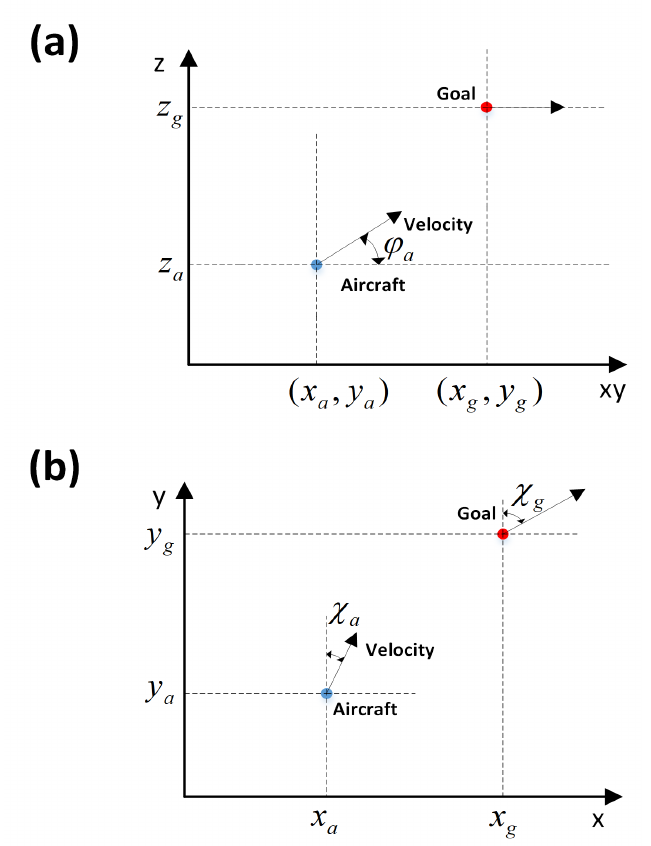
Figure 5. Kinematic model of aircraft: ( a ) kinematic model on a vertical plane and ( b ) kinematic model on a horizontal